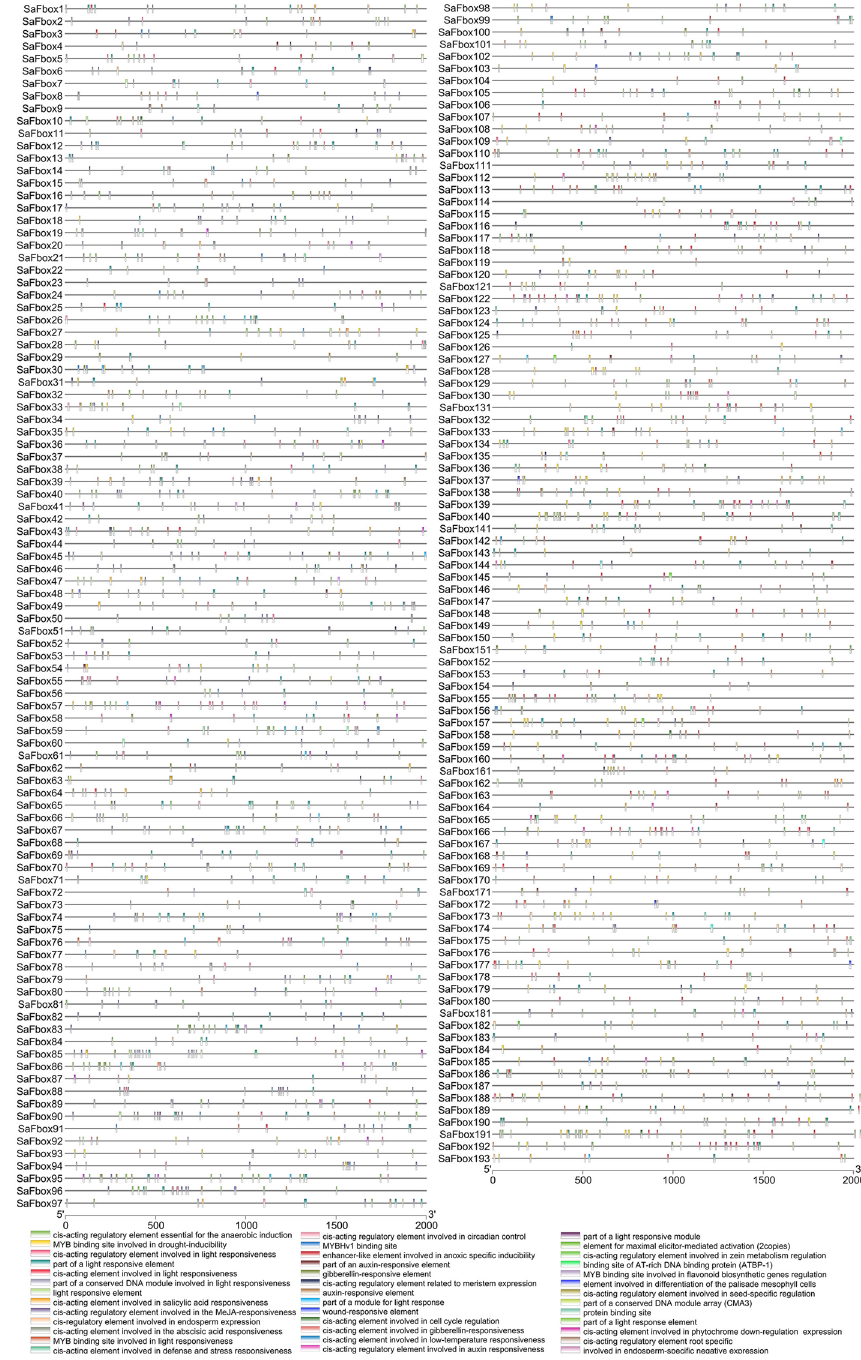
Figure 5. The distribution of related cis-acting elements from the promoters of SaFbox genes. Different boxes represent different cis-acting